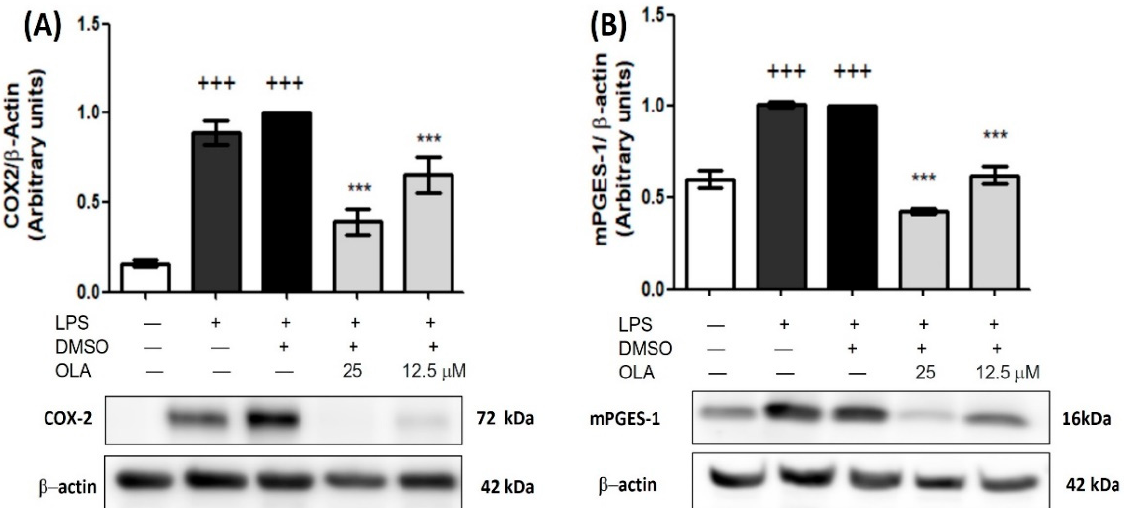
Figure 3. Effects of OLA on IL-1 β ( A ), TNF- α ( B ), IL-17( C ), IL-6 ( D ), and IFN- γ ( E ) levels. Cells were pretreated for 30 min(min) with OLA and LPS-stimulated (5 µ g/mL) for 18 h. Control cells were also treated with DMSO (solvent control) and LPS or nontreated. Data are expressed as means ± SEM ( n = 7). +++ p < 0.001 vs. control cells (no stimulated); * p < 0.05, ** p < 0.01, *** p < 0.001 vs. LPS − DMSO control-treated cells.